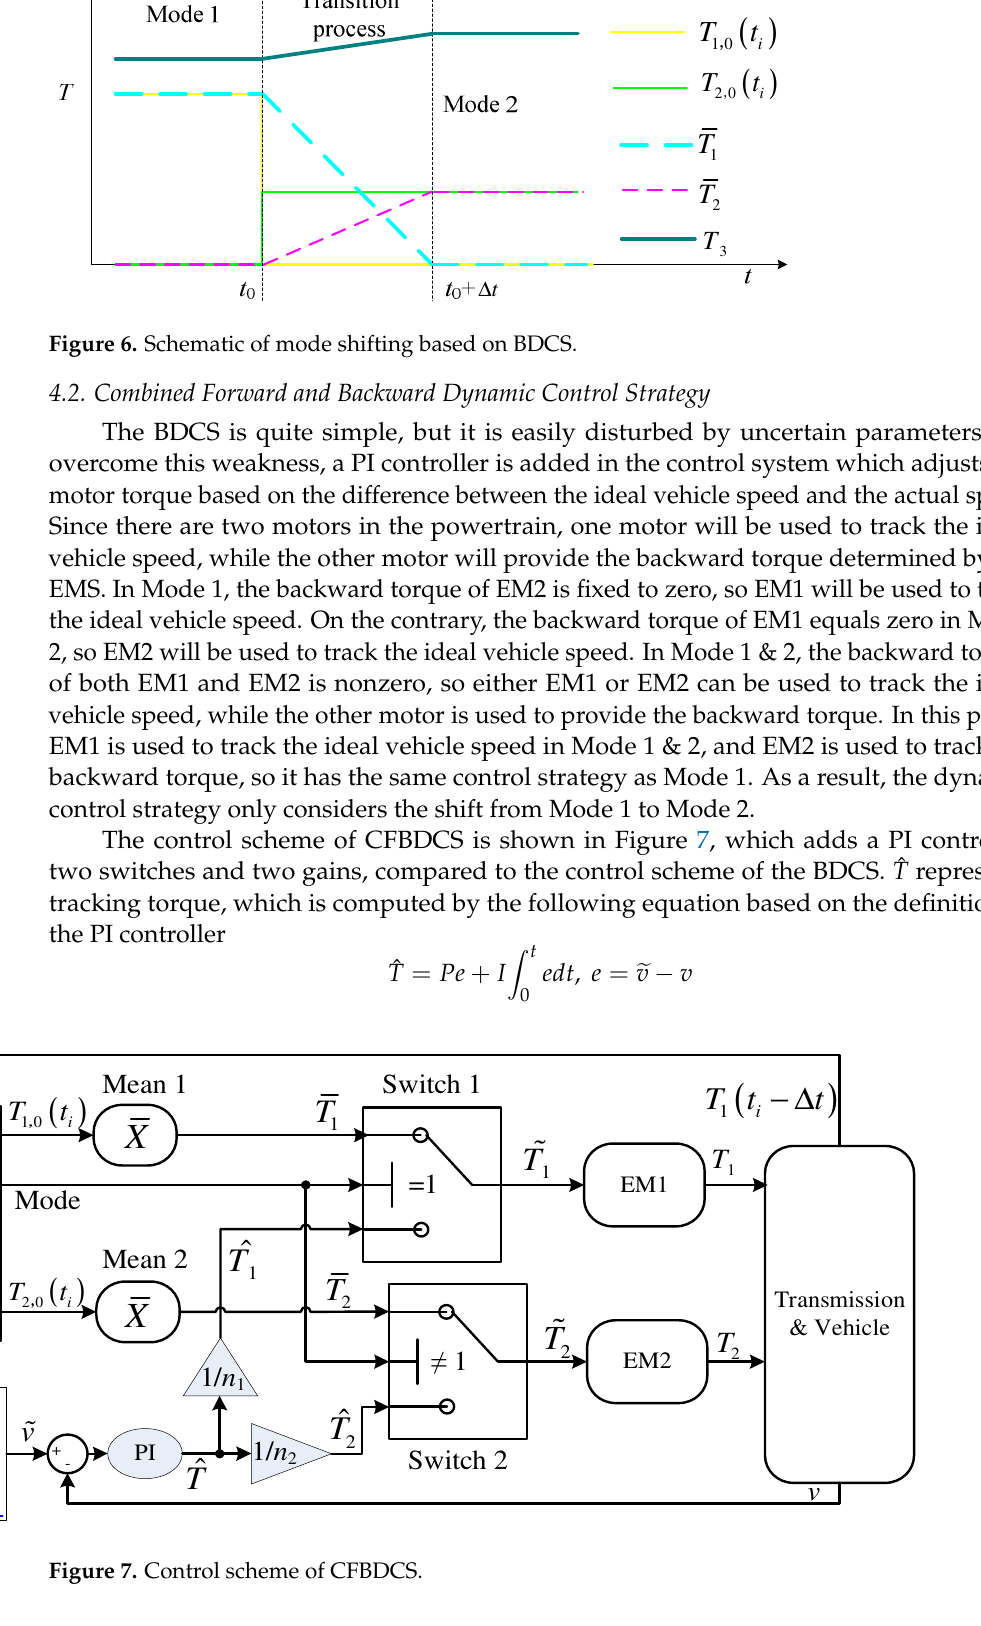
t ， Figure 5. Control scheme of BDCS. The ideal vehicle speed v ɶ and acceleration a ɶ are produced by the given driving cycle in the simulation. For practical driving, the ideal vehicle speed and acceleration can be obtained by the driver’s pedal signal. The EMS shown in Section 3 is based on the backward model, so it only computes the motor torque after the ideal vehicle speed and acceleration are provided. EMS is based on the backward-facing dynamic model, so the torque obtained from the EMS is named as backward torque in this paper. The EMS is called once per period of Δ t to implement the real-time control. As a result, the EMS outputs the step changing backward torque of EM1 and EM2 with step length Δ t , noted by T 1,0 ( t i ) and T 2,0 ( t i ). To avoid the step change of backward torque, the mean operation X over a running window with the time width of Δ t is added after the backward torque signal, which makes the backward torque continuous, noted by